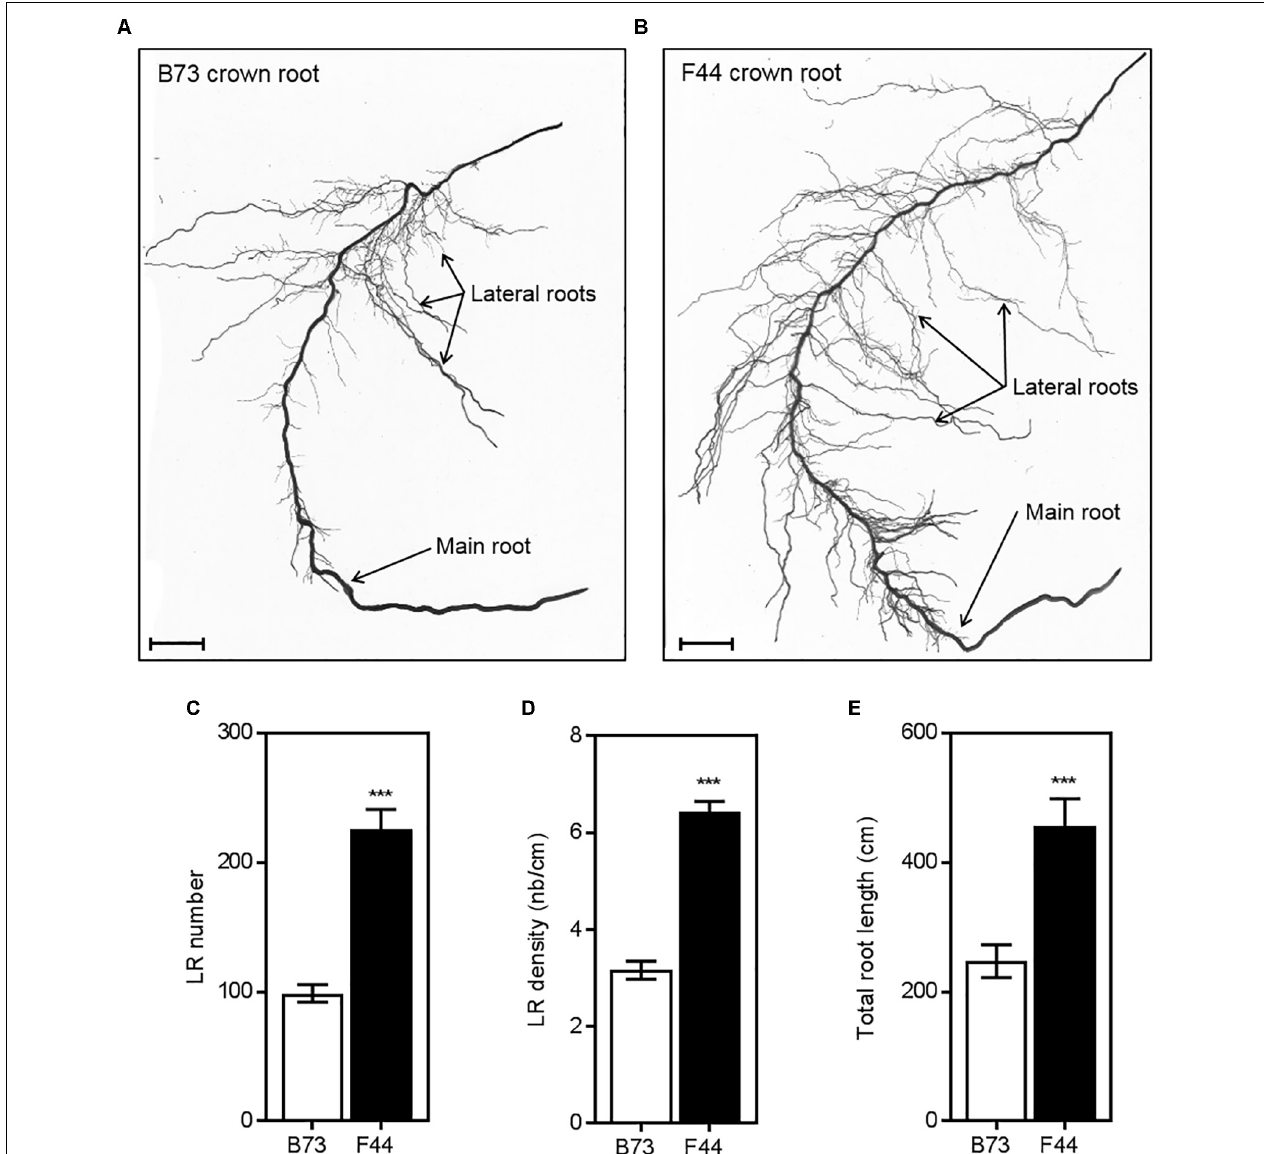
FIGURE 5 | Comparison of crown root architecture of B73 (A) and F44 (B) maize inbreds. Measurements of lateral root numbers (C) , lateral root densities (D) and total root lengths (E) of B73 (white) and F44 (black) crown roots. Values are means ( ± SE) from five individual plants. Similar results were obtained in another independent experiment. Scale bars = 25 mm. Asterisks indicate significant differences between lines at ∗∗∗ P < 0.005 (Student’s t